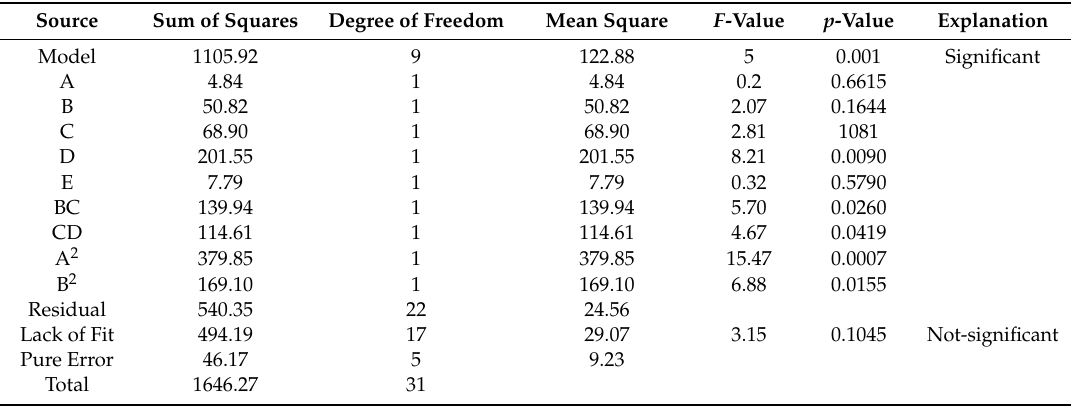
Table 7. Analysis of variance for zinc recovery.